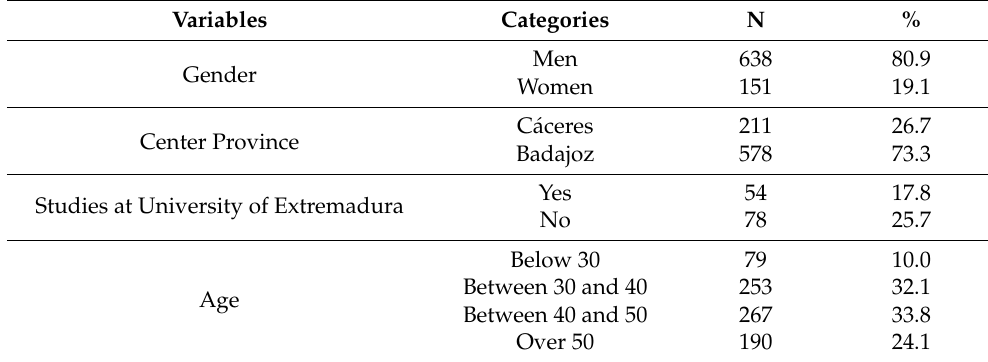
Table 1. Sample’s sociodemographic characteristics (N =